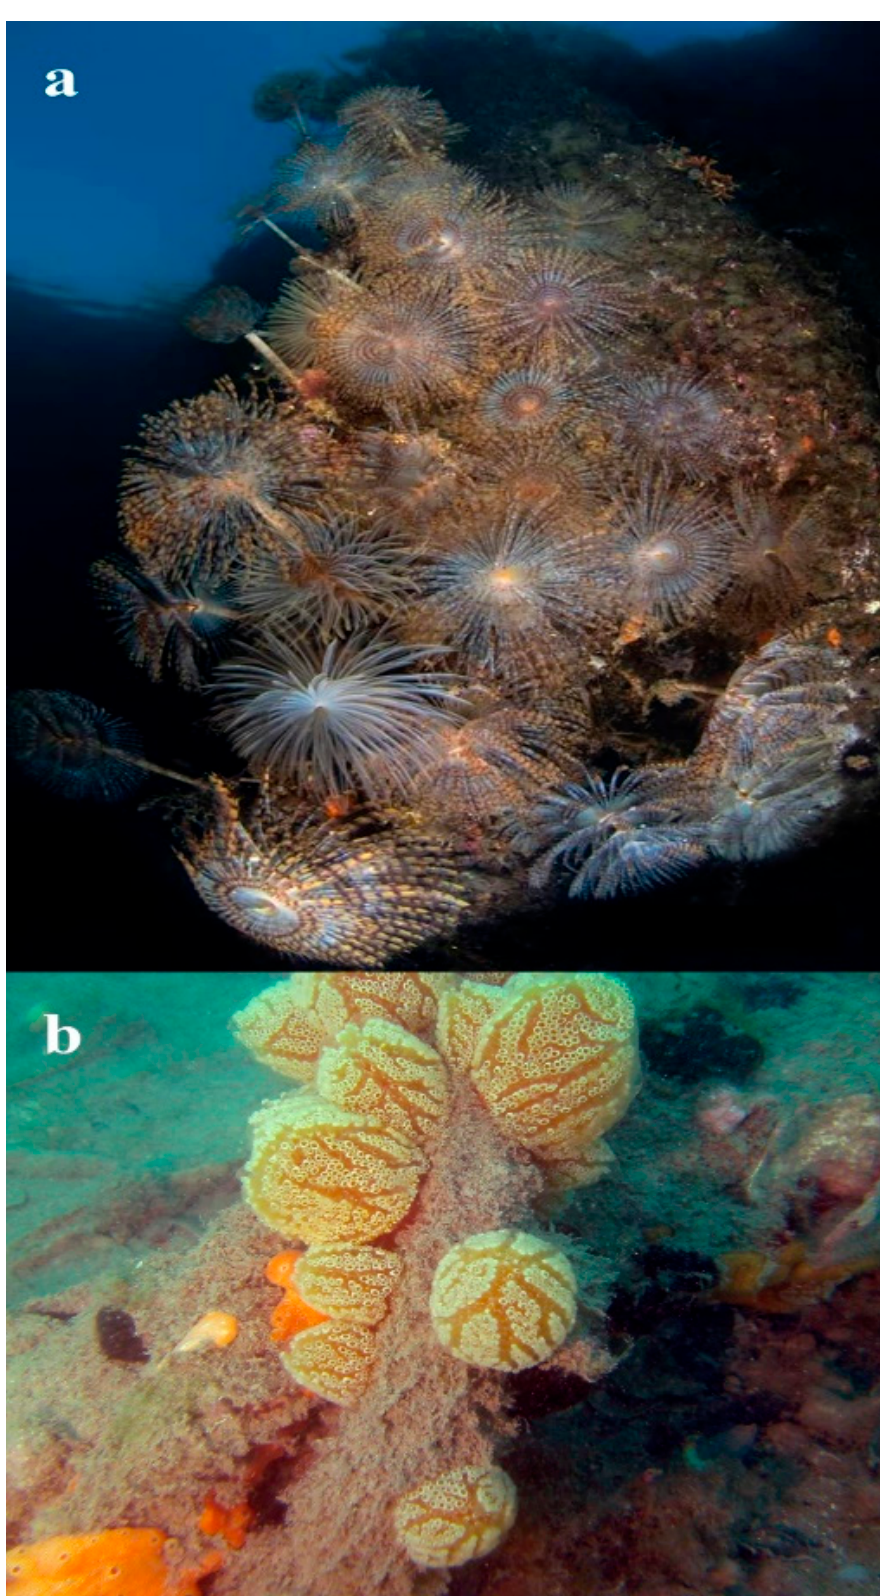
Figure 2. Artificial hard substrata around mariculture in a biodiversity hotspot: ( a ) a rich polychaetes community, mainly made up of Sabella spallanzanii (photo: courtesy of Gianluca Romano); ( b ) a dense tunicates population with numerous specimens of Distaplia cfr bermudensis .